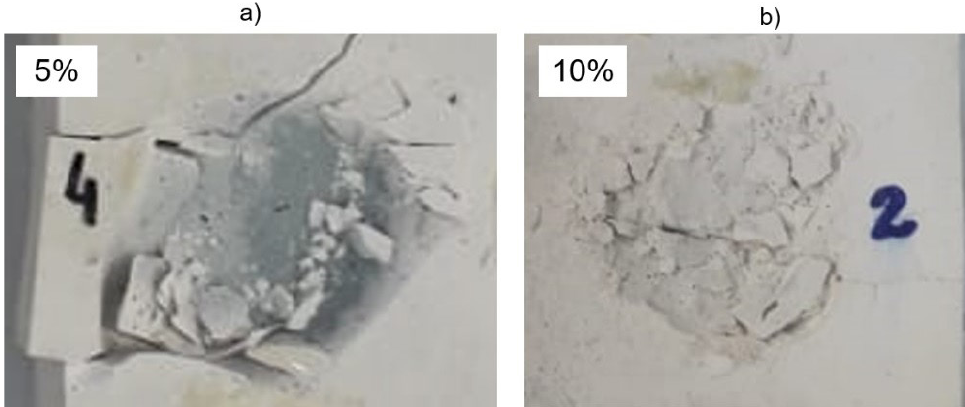
Figure 9. Detail of the fracture surface of a sample bonded with (a) epoxy and (b) polyurethane